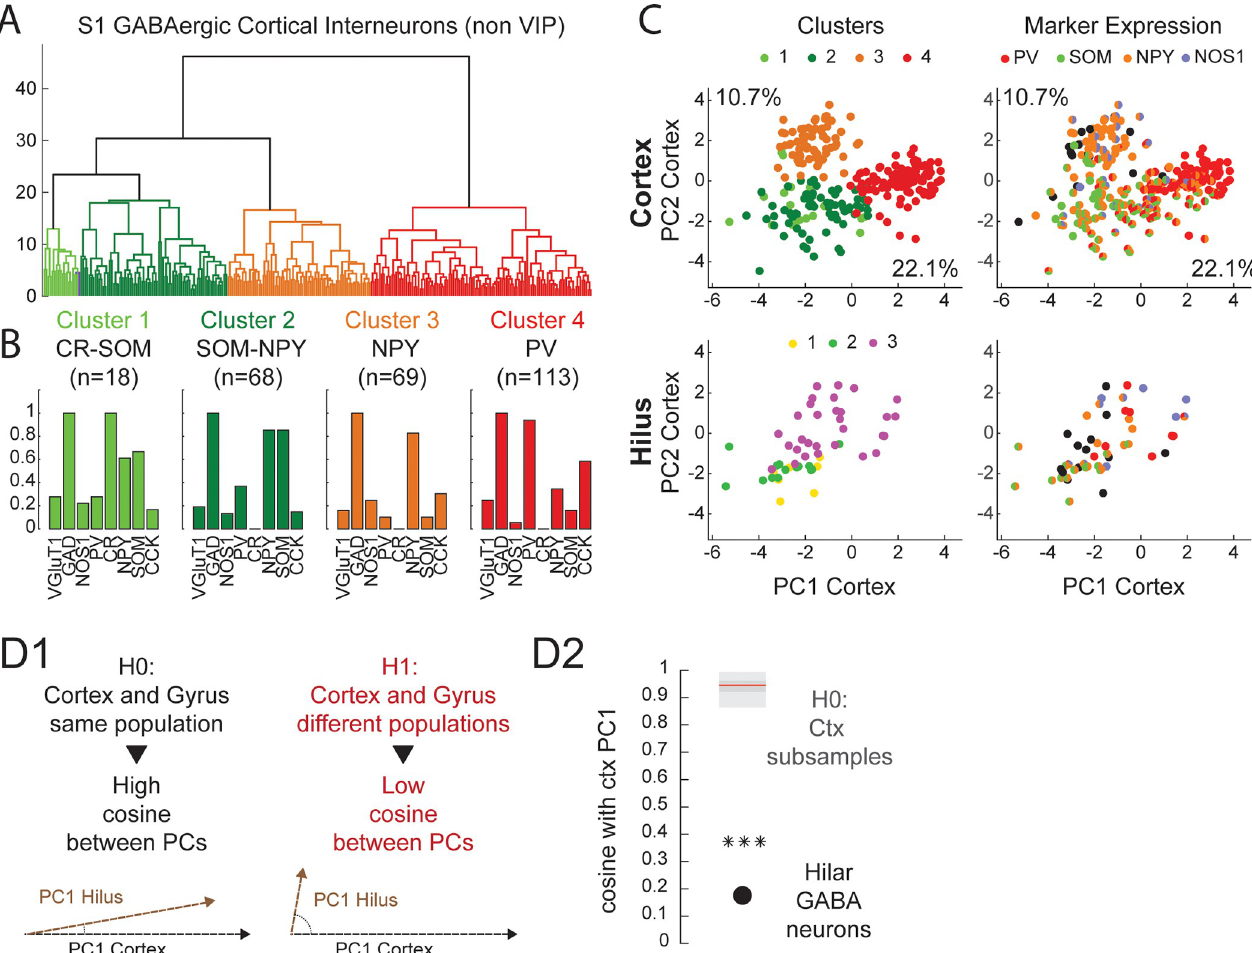
Fig 4. Hilar GABAergic neurons do not diversify along the same axes as cortical interneurons. A: Hilar GABAergic neurons were compared to a sample of 268 GABAergic interneurons recorded in the primary somatosensory cortex (S1). VIP neurons were excluded as this marker is not expressed by hilar GABAergic neurons. Ward’s analysis based on the parameter used in Fig 2A segregated cortical interneurons in four clusters (x-axis: neurons; y-axis: distance of aggregation). B: Histograms of cortical interneurons expression of molecular markers. Cluster 1 neurons expressed CR and SOM, cluster 2 expressed SOM and NPY, cluster 3 expressed NPY and cluster 4 expressed PV. C: Clusters (left) and marker expression (right) of cortical (top) and hilar GABAergic neurons (bottom) projected on the two first principal components (PC) of the cortical population Percentages besides the x and y axes indicate the fraction of the cortical sample variance explained by the first and second principal components respectively. There is no obvious correspondence between clusters of GABAergic neurons in the gyrus and the cortex. D: The axes of maximum variance of cortical and hilar GABAergic neurons are not aligned. 1: Sketch illustrating the H0 and H1 hypotheses in a Principal Component Analysis (PCA) based test of multiparametric variance alignment. Under H0, hilar and cortical GABAergic neurons come from the same population and their principal components (PC) have a high collinearity (cosine around 1). Under H1, hilar and cortical GABAergic neurons come from different populations and their principal components (PC) have a low collinearity (cosine around 0). The distribution of the PC cosines under H0 was estimated by subsampling 51 cortical neurons 1000 times. 2: Actual value of PC cosine between cortical and hilar GABAergic neurons overlaid on H0 distributions (light grey: 2.5–25% and 75–97.5% percentiles; dark grey: 25–75% percentiles; red line: median). The alignment is significantly lower than expected from neurons sampled from the same population ( ��� : p < 0.001).